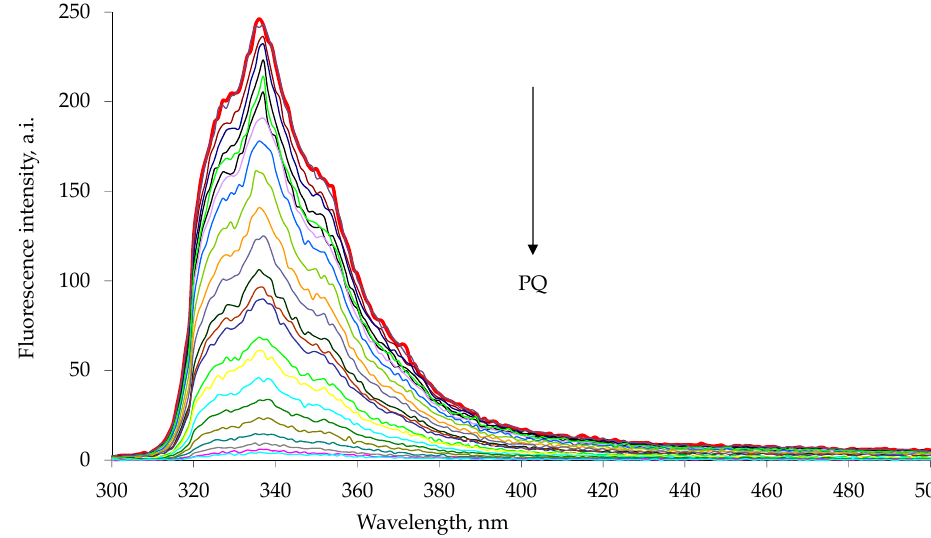
Figure 3. Fluorescence quenching of 1a host with increasing paraquat concentration, PQ, in chloroform–methanol 1:1 solution at 25 °C. The experimental data are reported in Table 1. The emission spectra were measured with excitation at 285 nm. Each spectrum is reported with different color line (Entry 1–25 Table 1). Table 2. Experimental data for the determination of spectra reported in Figure 4. The V 1b and V PQ volumes refer to an initial 1b solution with a concentration of 50.7 μ g L − 1 and paraquat, PQ, solution with a concentration of 1000 μ g L − 1 , respectively. The final volume of each solution was made up to a total volume of 4000 μ L by fixing with the solvent mixture. Entry